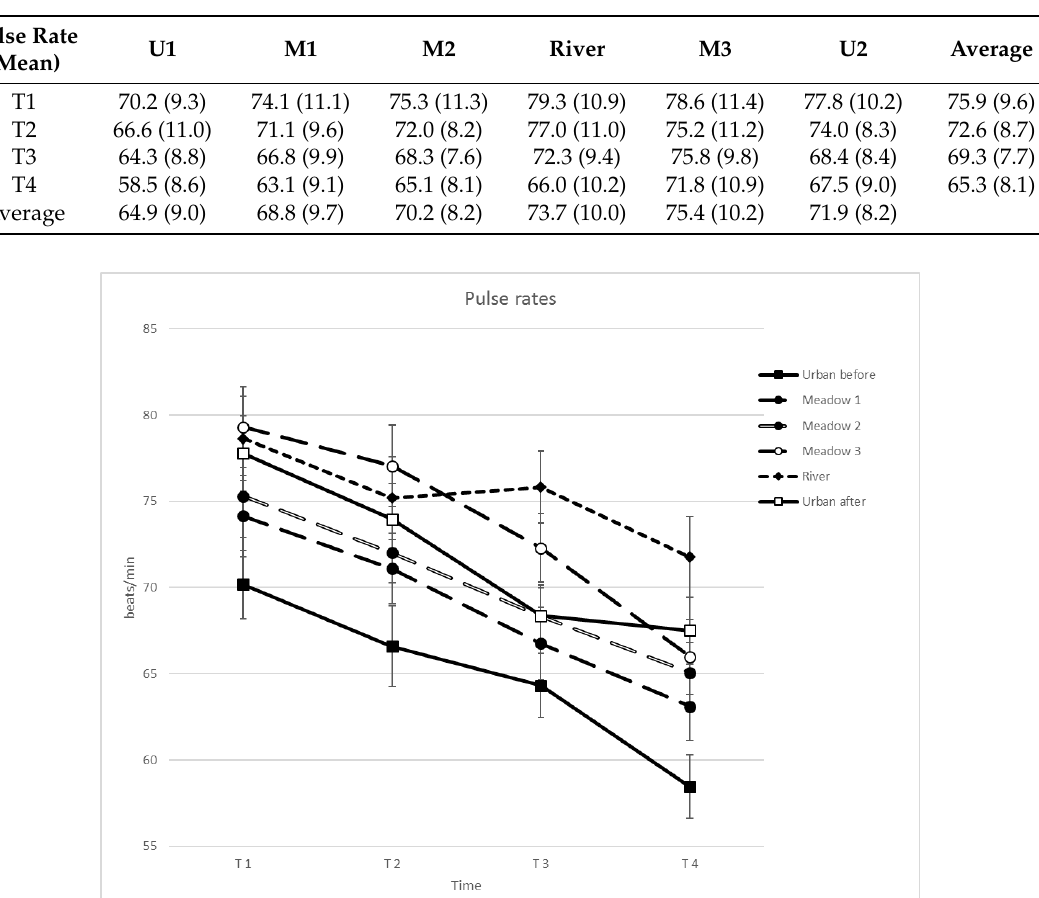
Table 3. Means and SD (in brackets) of pulse rates per study site ( N = 22).